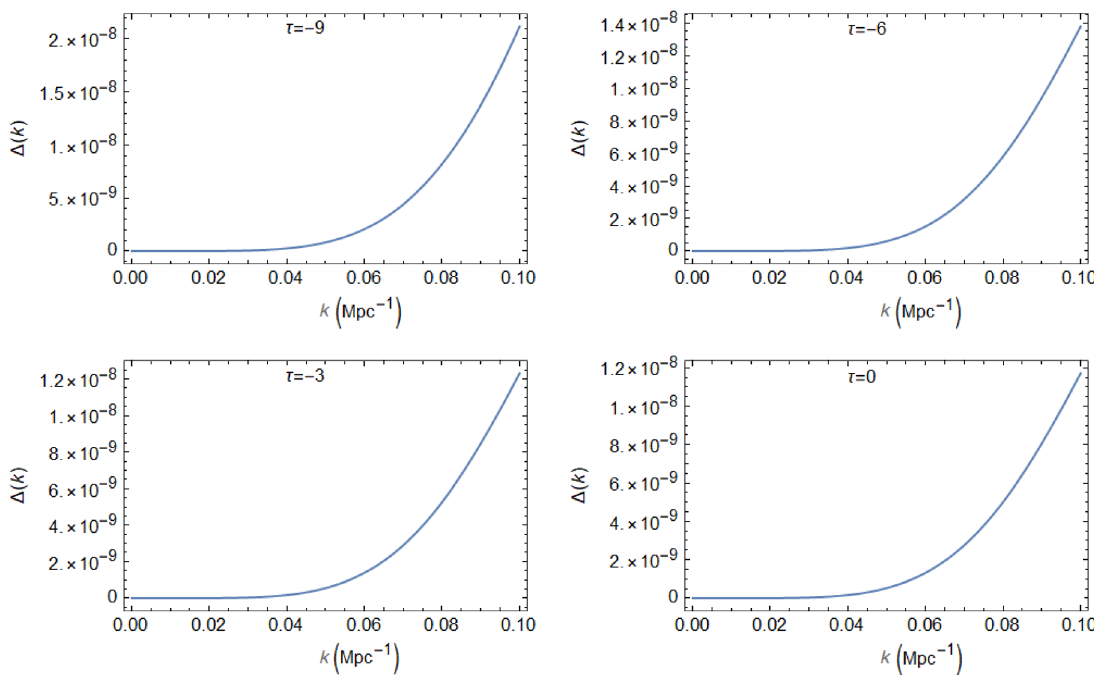
Fig. 1 (cid:16)( k ) vs k using the perturbative method at four different values of τ